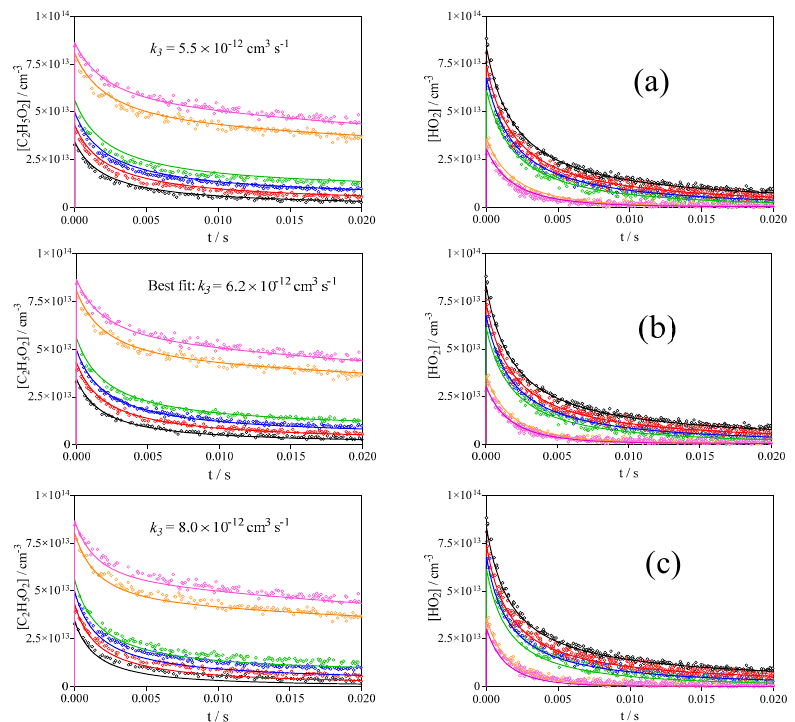
Figure 6. C 2 H 5 O 2 (left graphs) and HO 2 (right graphs) concentration time profiles for a total radical concentration of 1.2 × 10 14 cm − 3 . C 2 H 5 O 2 absorption time profiles have been converted using σ = 1.0 × 10 − 20 cm 2 . Centre graphs ( b ): best fit with k 3 = 6.2 × 10 − 12 cm 3 molecule − 1 s − 1 , upper graphs ( a ): model with of k 3 = 5.5 × 10 − 12 cm 3 molecule − 1 s − 1 , lower graphs ( c ): model with k 3 = 8.0 × 10 − 12 cm 3 molecule − 1 s − 1.